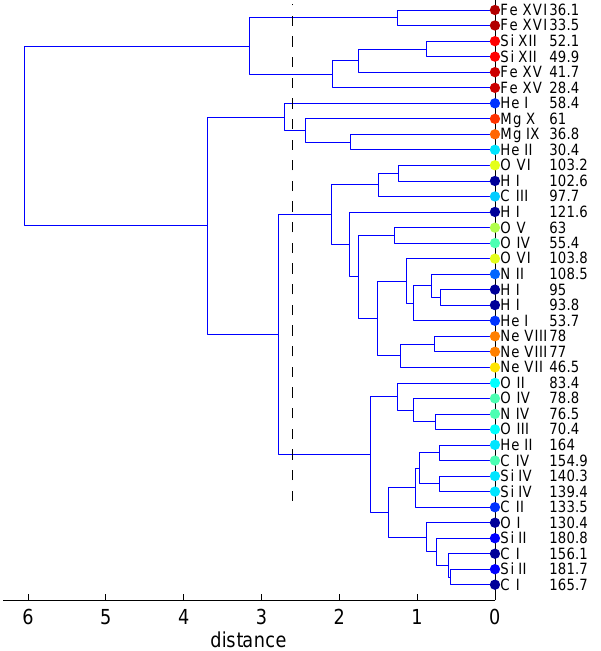
Fig. 6. Dendrogram of the 38 spectral lines using an average dis- tance linkage between all lines. The colour code associated with each line is indicative of the characteristic temperature, using the same scaling as in Fig. 5.